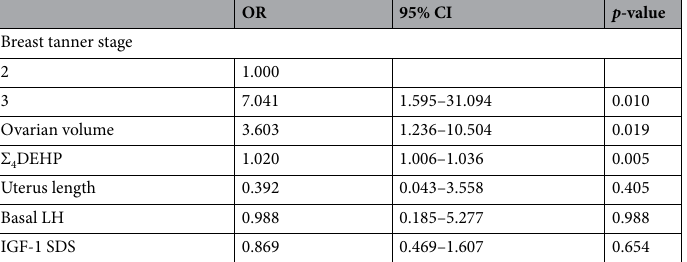
Table 4. Independent risk factors affecting progression of isolated premature thelarche. Σ 4 DEHP MEHHP [mono (2-ethyl-5-hydroxyhexyl) phthalate] + MEOHP [mono-(2-ethyl-5-oxohexyl) phthalate] + MCEPP [phthalatemono (5-carboxy-2ethylpentyl) phthalate] + MCMHP {mono-[(2-carboxy methyl) hexyl] phthalate}, LH Luteinizing hormone, IGF-1 Insulin-like growth factor-1, SDS Standard deviation score, OR Odds ratio, CI Confidence